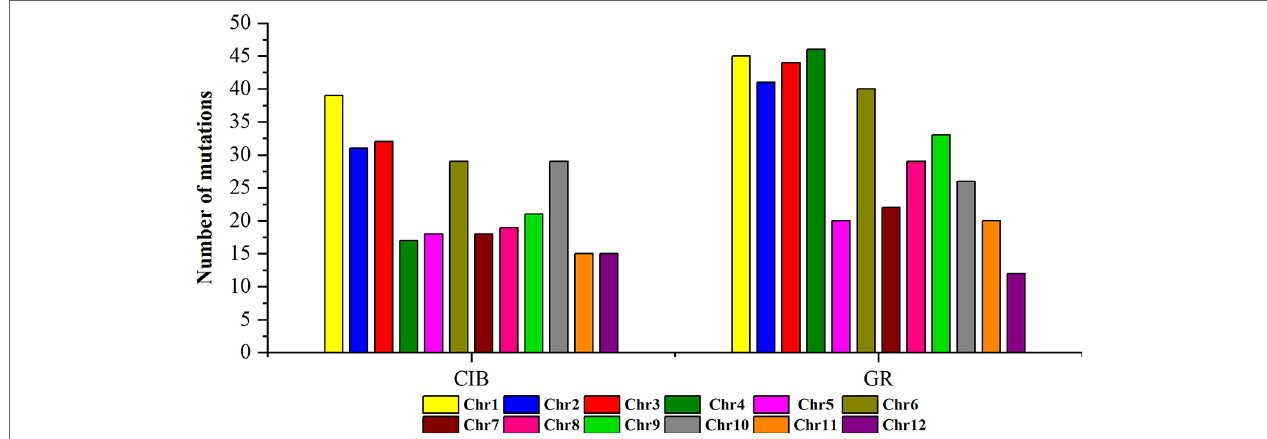
FIGURe 3 | The numbers of mutations detected for on different chromosomes induced by CIBs and GRs in all the mutants.